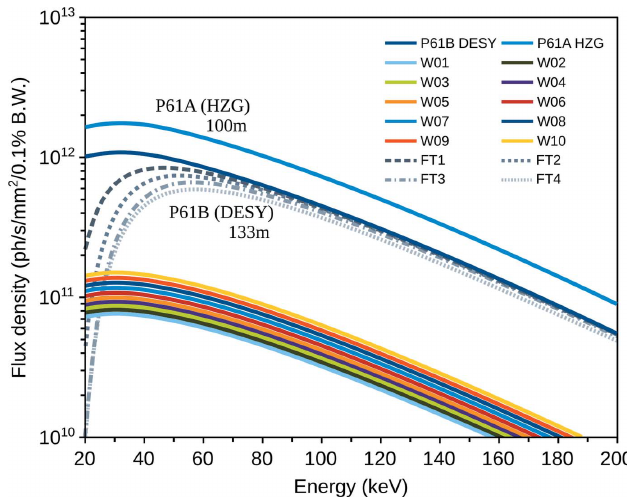
Figure 3 Flux density [photons s (cid:4) 1 mm (cid:4) 2 (0.1% bandwidth) (cid:4) 1 ] calculated for the damping wigglers of P61 using SPECTRA (Version 10.2; Tanaka & Kitamura, 2001). The individual contributions of each of the ten damping wigglers are shown, as well as the total flux at P61A and P61B ( i.e. due to the large horizontal beam divergence, at a greater distance, less flux is expected at P61B in a 1 mm 2 aperture than at P61A). The calculation of the successive contributions of 1 to 4 heat-load filters (FT) are also shown for